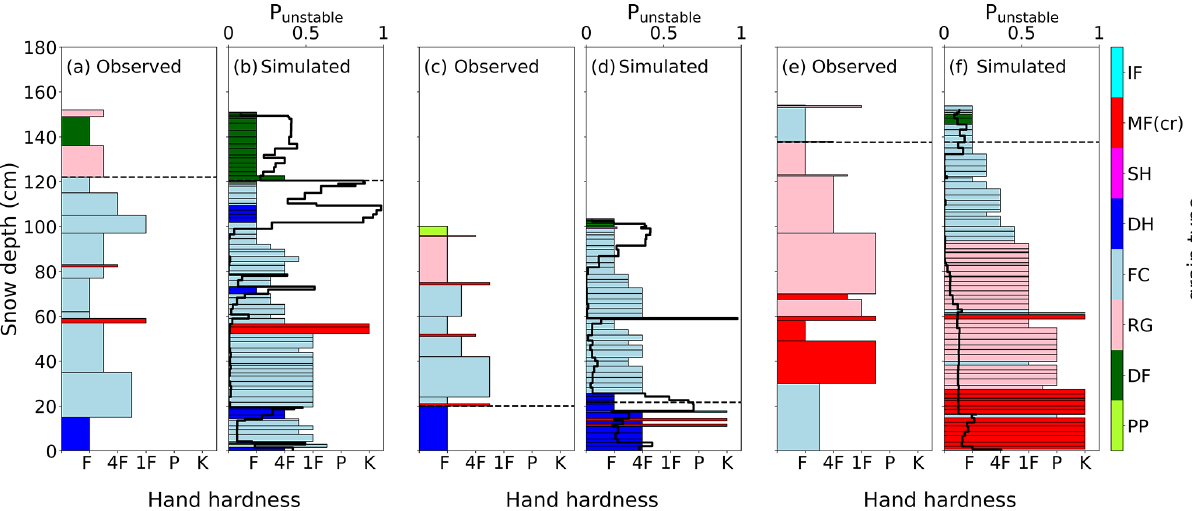
Figure 9. Three profile pairs from the DAV data set with ( a , c , e ) manually observed snow profiles and ( b , d , f ) corresponding simulated snow stratigraphy obtained with SNOWPACK. Hand hardness and grain type (colors) were coded after Fierz et al. (2009) (for further explanation see caption of Fig. 3). The dashed horizontal line in the manual profile displays the observed height of the RB failure layer, and the corresponding manually determined layer is indicated by a dashed line in the respective simulated profile. The black line in the simulated profiles shows the probability of instability P unstable determined for each layer. Observed RB results were (a) RB score 2, whole block; (b) RB score 6, edge; and (c) RB score 4, partial. The local danger level estimates were (a) LN = 3, (b) LN = 2 and (c) LN =